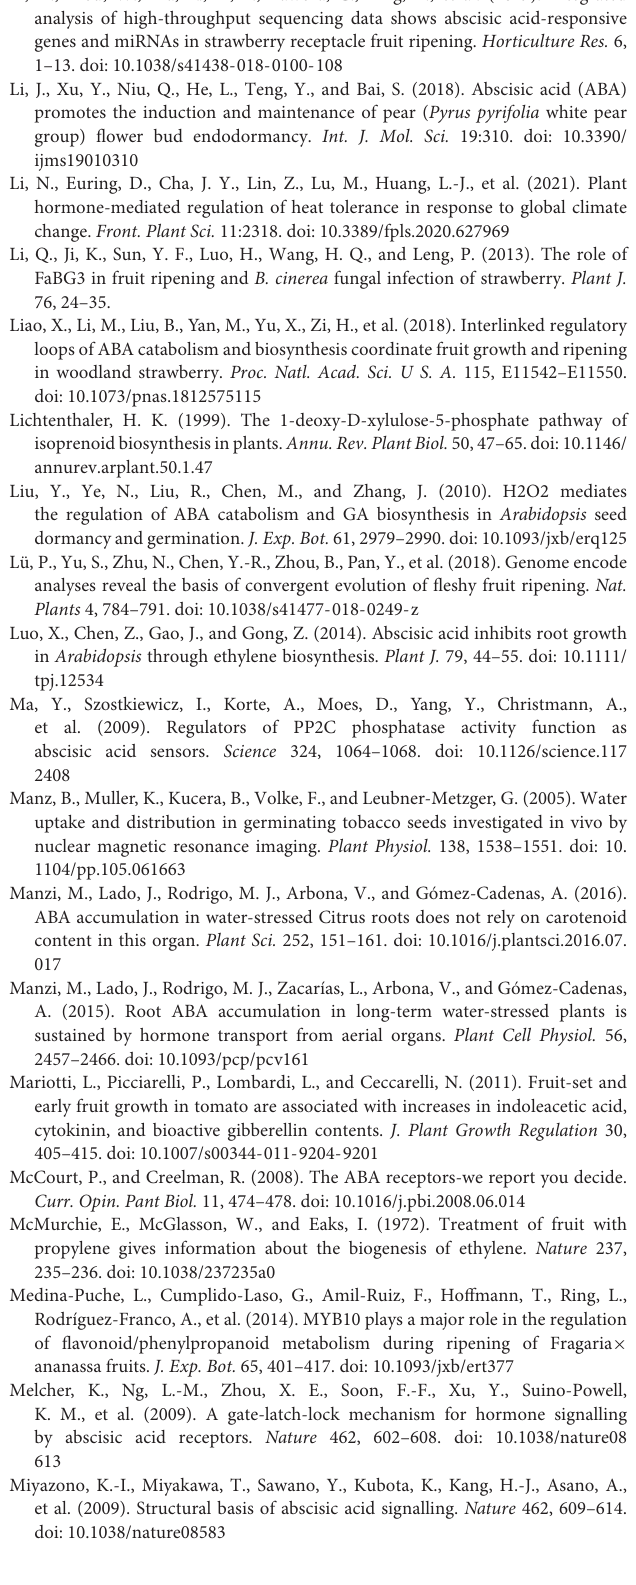
Frontiers in Plant Science |